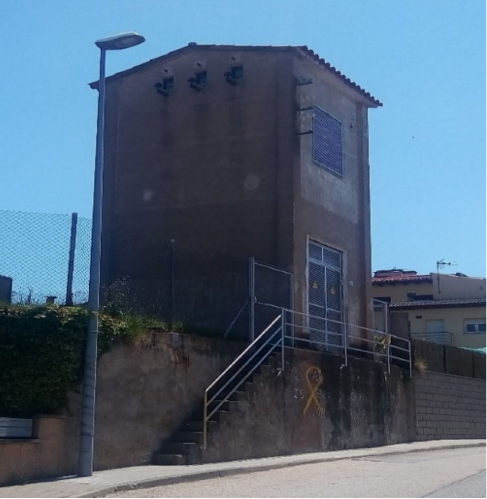
Figure 5. A picture of SS-B where the PED and the batteries were installed.